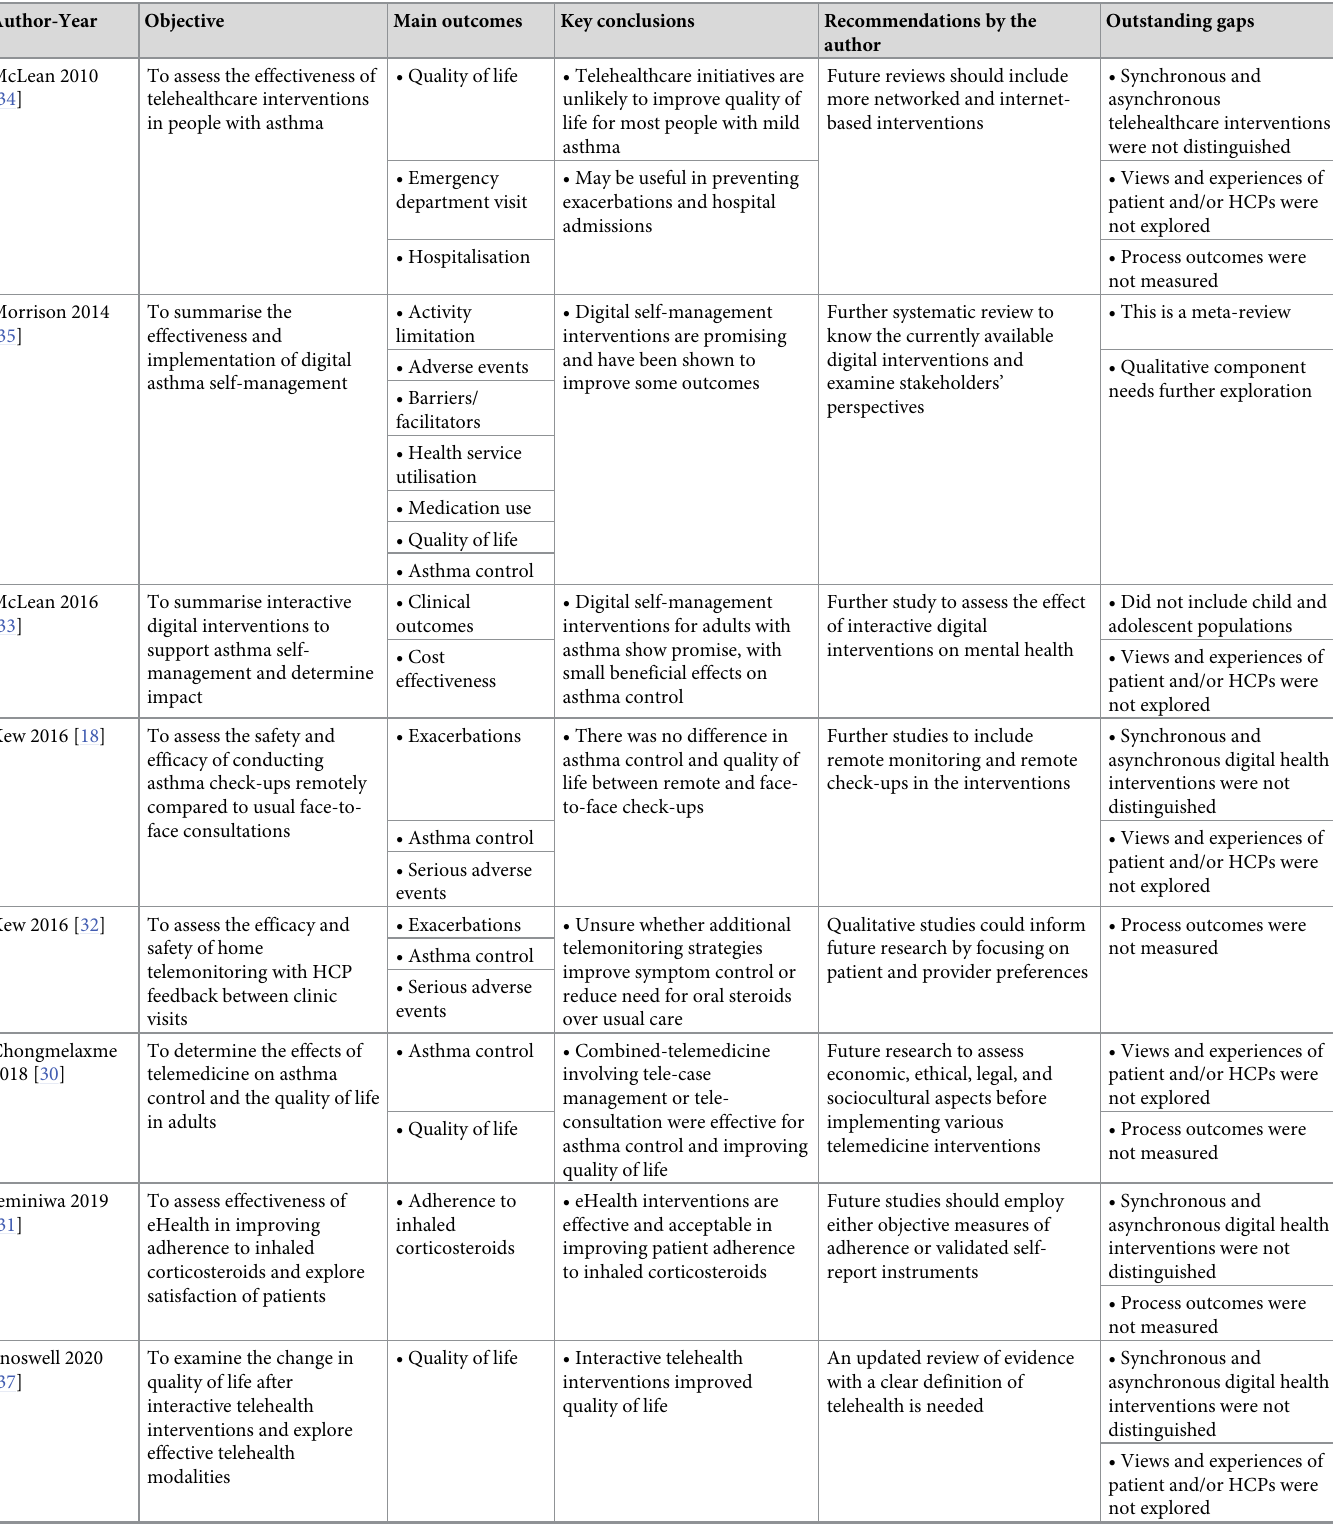
Table 1. Summary of relevant published reviews (ordered by publication